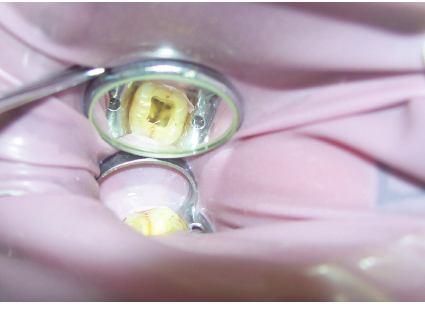
Figure 1: Access opening.